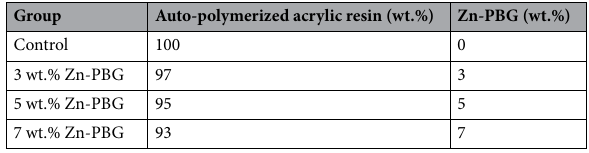
Table 1. Compositions of the control and experimental groups in this